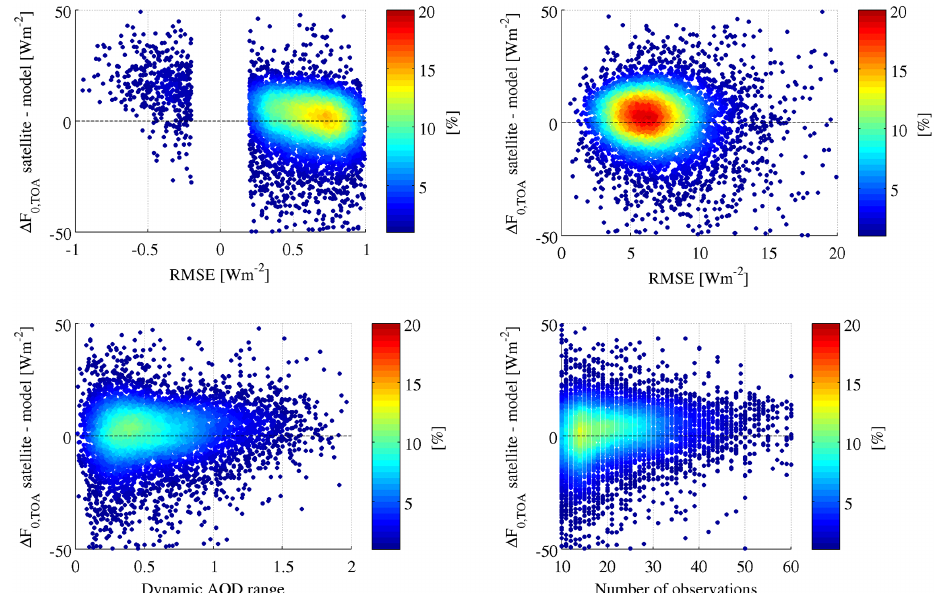
Figure 11. Differences between satellite-based and modeled F 0 , TOA as a function of (a) correlation coefficient between CERES fluxes and MODIS AODs, (b) RMSE of the linear fitting, (c) dynamic AOD range (the difference between grid cell monthly maximum and minimum AOD values) and (d) number of observations in a grid cell/month. The color scale denotes percent of the